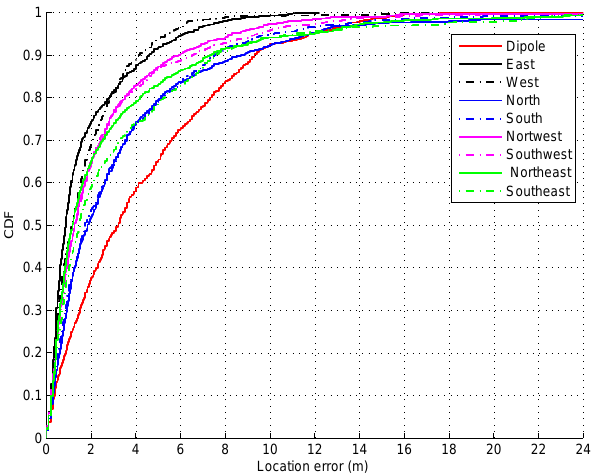
Figure 5: CDF comparison of dipole and 60 ◦ beam directional antenna.